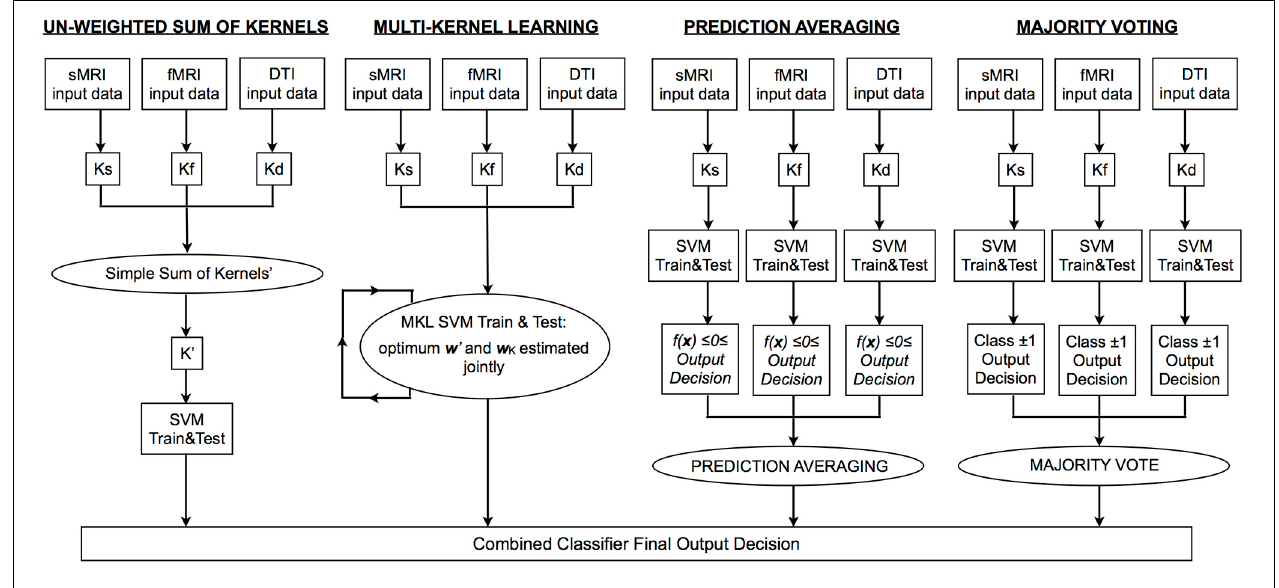
FIGURE 1 | Flowchart depicting the processing pipeline for each type of integrative approach. MRI, magnetic resonance imaging; sMRI, structural MRI; DTI, diffusion tensor imaging; fMRI, functional MRI; Ks/f/d, kernel matrix for sMRI/fMRI/DTI data; SVM,